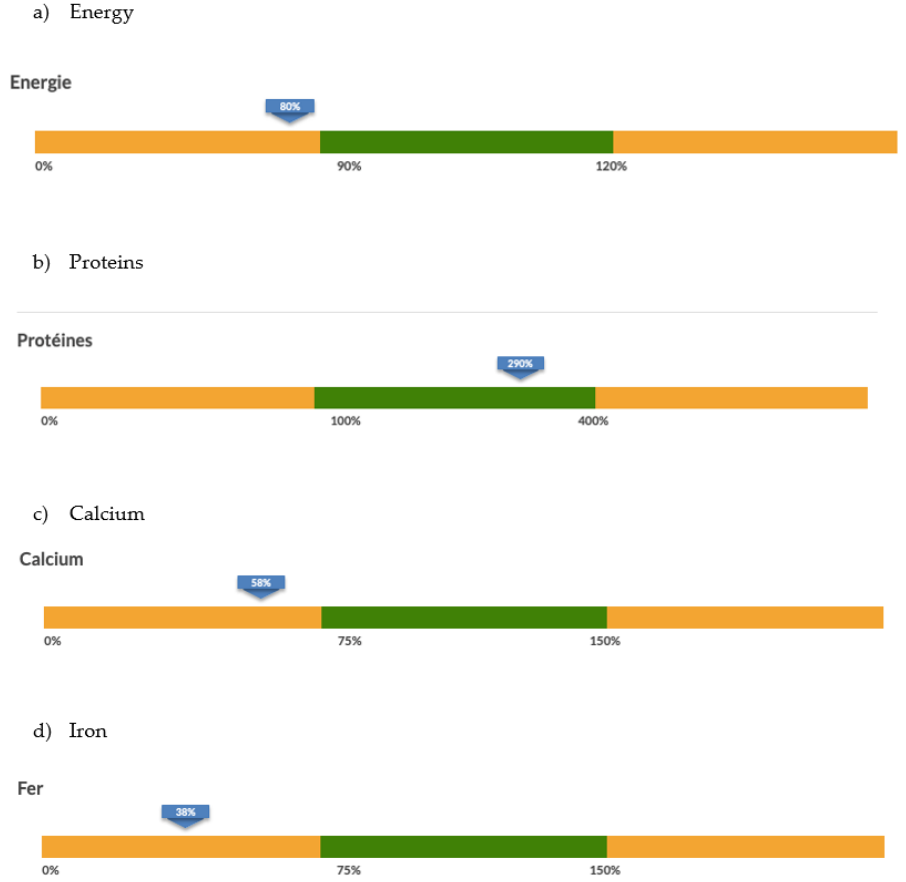
Figure 3. Screenshot of the Nutricate© individual dietary counseling report.